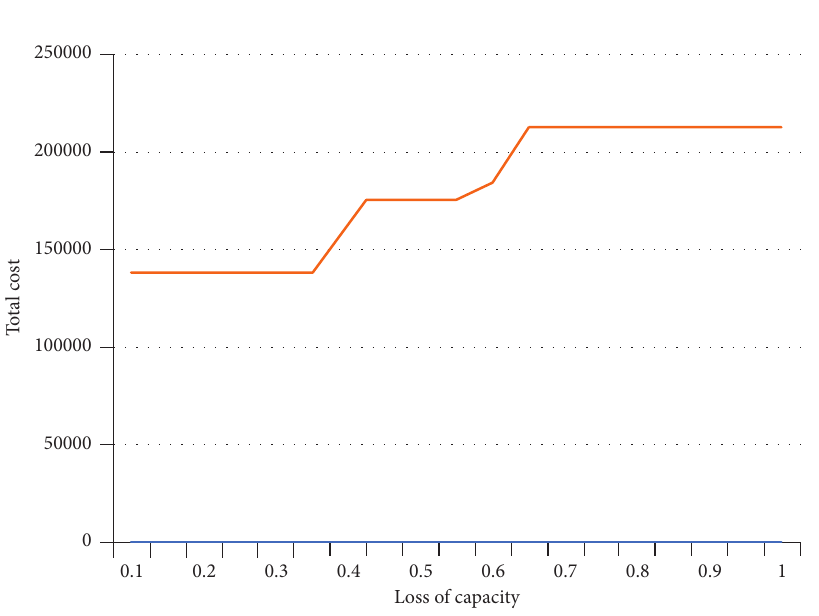
Figure 4: Total cost versus loss of